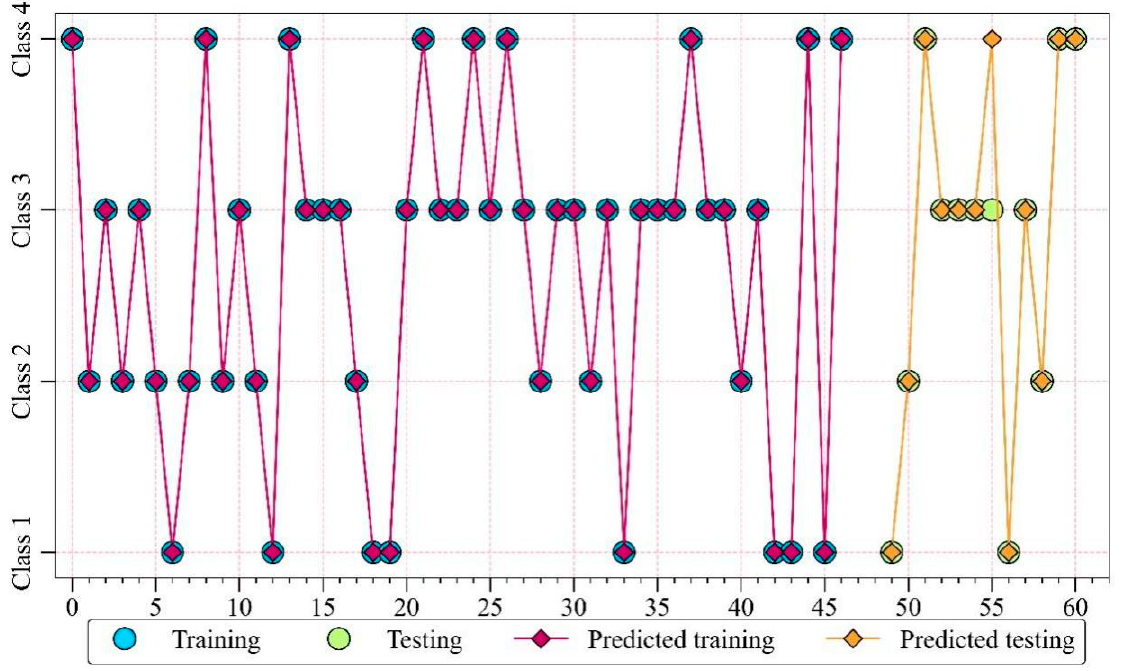
Figure 8. The classification results on training and testing datasets of the WOA–RF model.